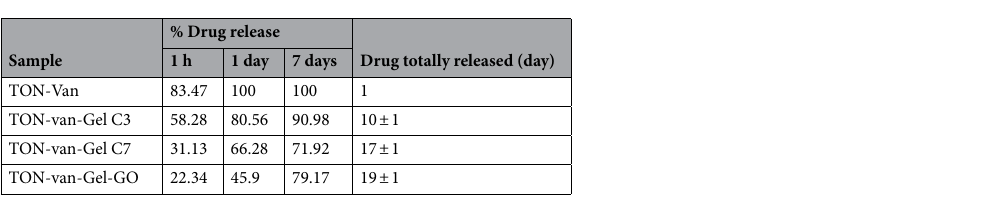
Table 4. Vancomycin release profile from different